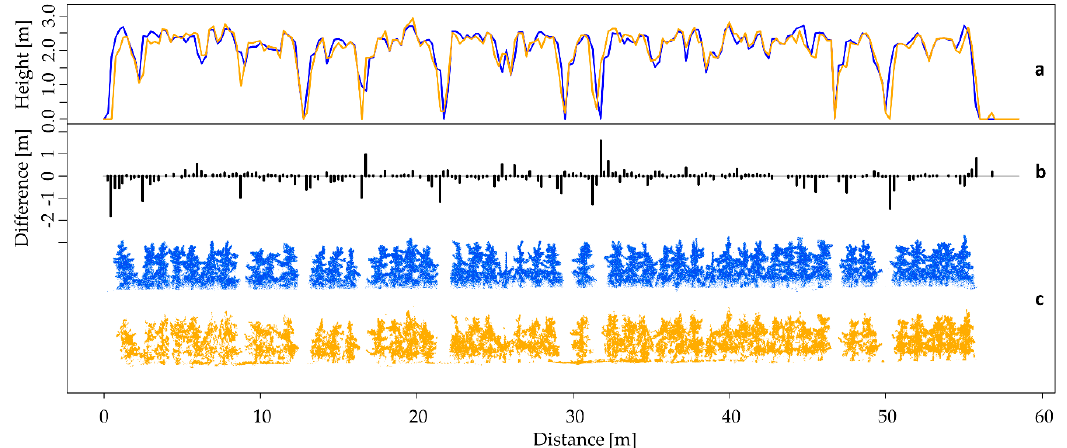
Figure 5. ( a ) Tree wall height estimations from UAV (orange) and LiDAR (blue) point clouds for each grid cell in apple tree row C for 2018. ( b ) Difference in maximum tree wall height estimations between UAV and reference point cloud ( c ).